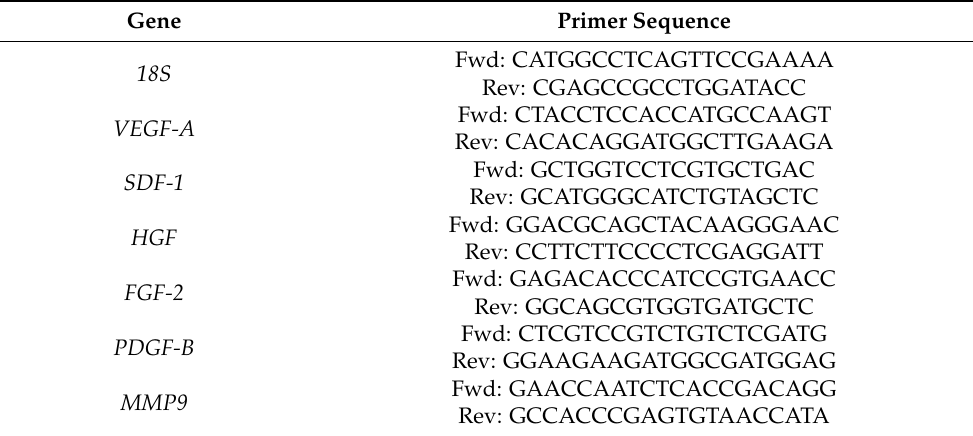
Table 1. List of the primers used in the